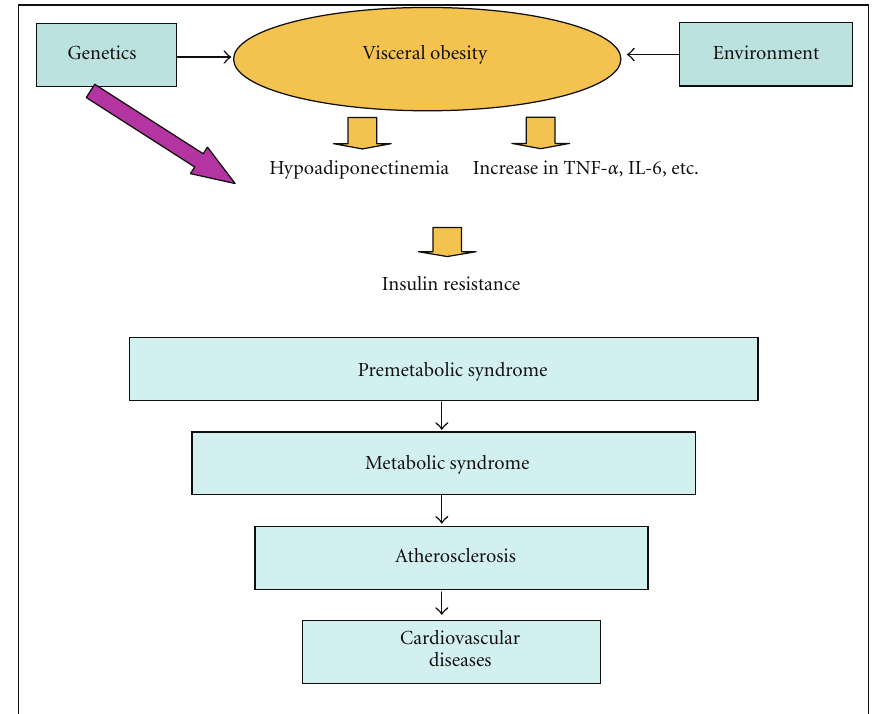
Figure 2: Progression and outcomes of visceral